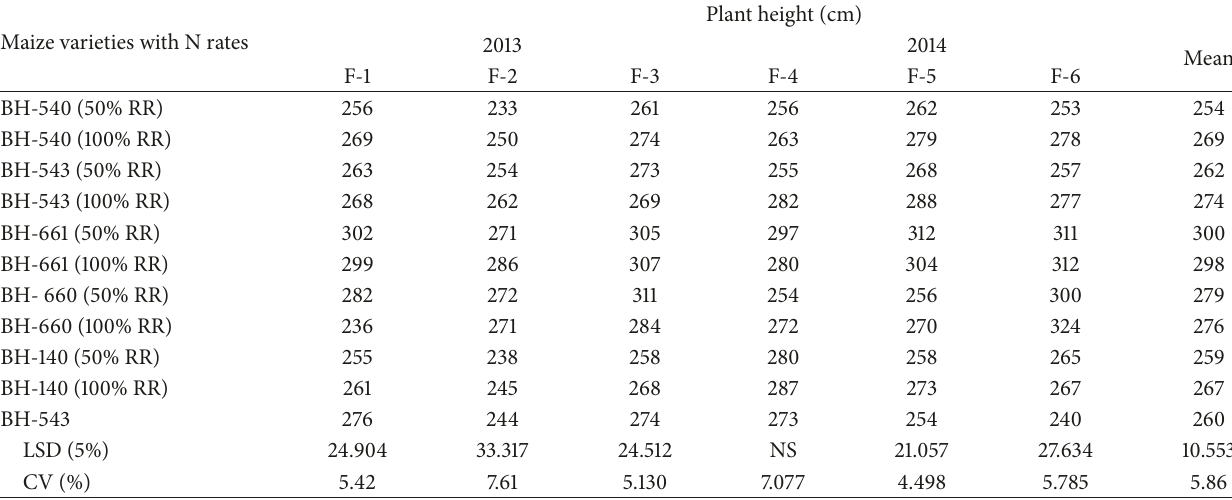
Table 5: Combination effects of varieties and nitrogen rate on mean plant height of maize on farmer’s field around Bako Tibe, western Ethiopia.